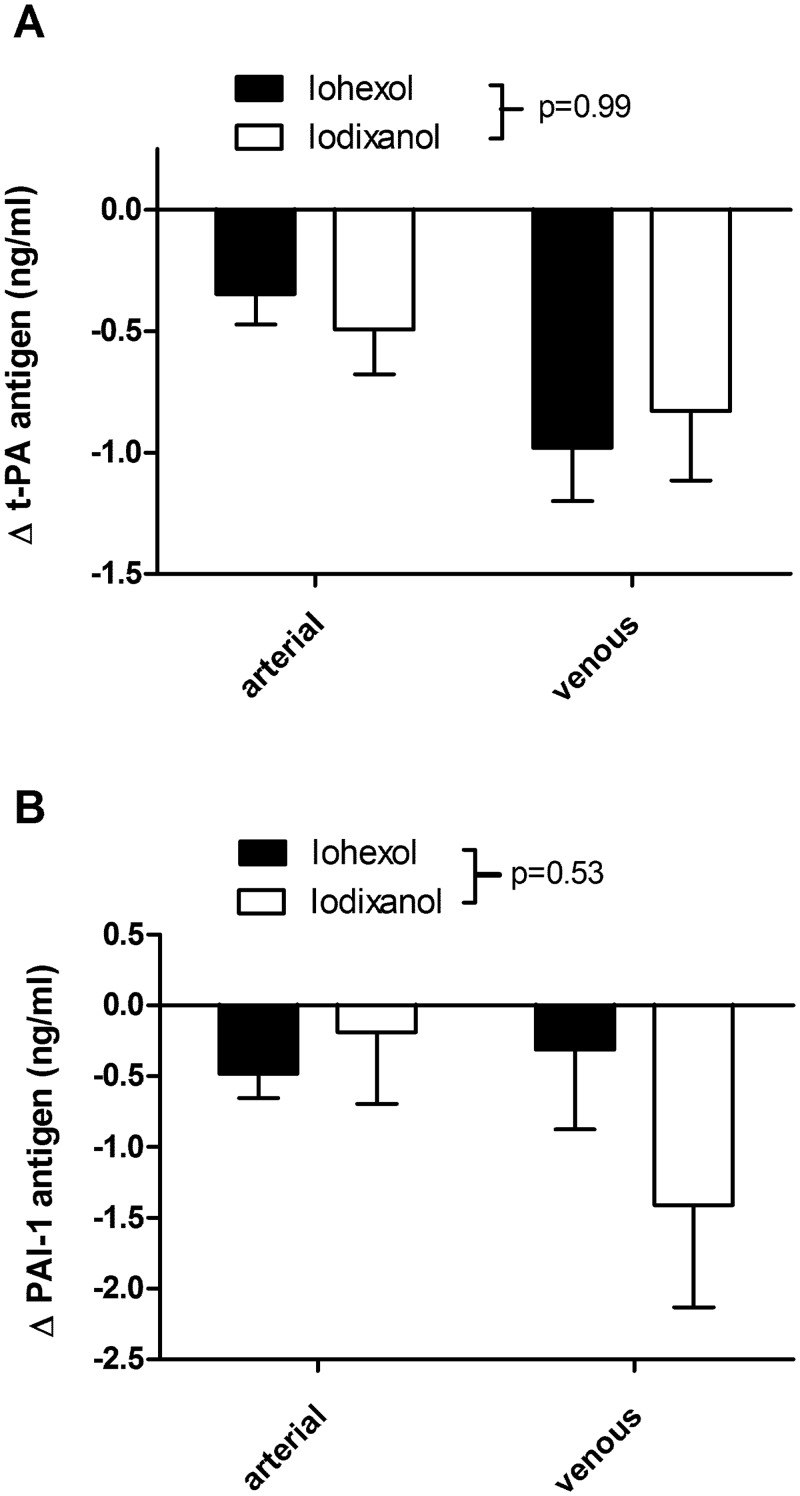
Change in (A) t-PA and (B) PAI-1 antigen in arterial and venous blood samples post-angiography compared to baseline in patients receiving iohexol and iodixanol.There was no significant difference between the groups (2-way repeated measures ANOVA, P value shown is between treatment groups; n = 6 in each group). There was no interaction between treatment groups and arterial/venous plasma.